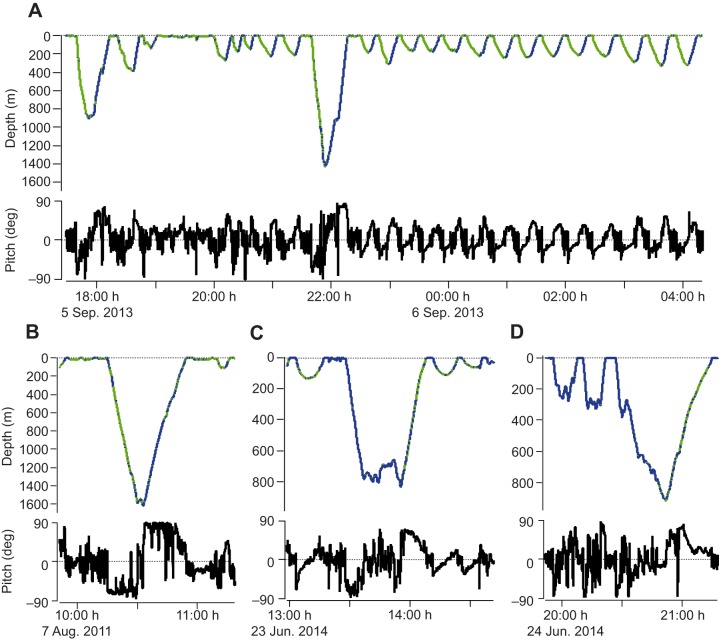
Example
data records for diving profile and pitch. Top: dive profile with gliding periods indicated in green and stroking periods in blue; bottom: pitch. Examples are taken from whale subjects 06Sep2013 (A), 07Aug2011(B), ha14_174b (C) and ha14_175a (D).